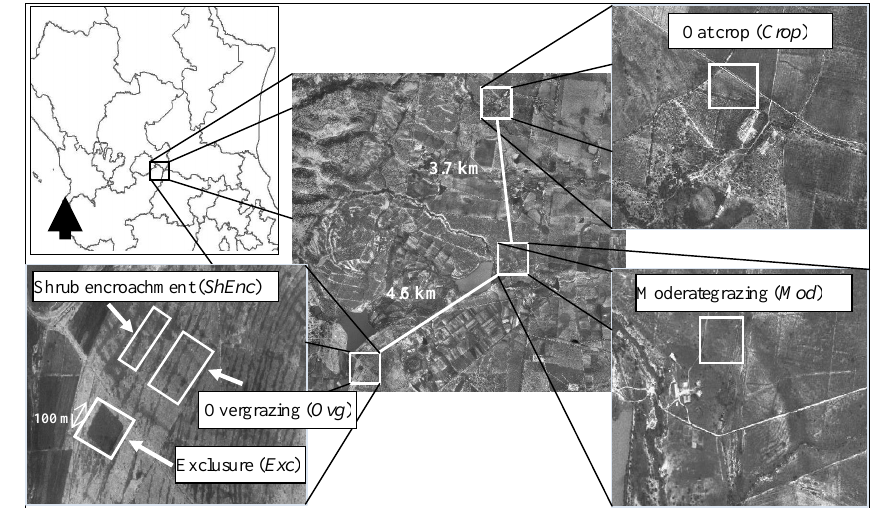
Fig. 1. Location of the study sites in Llanos de Ojuelos, Jalisco in central